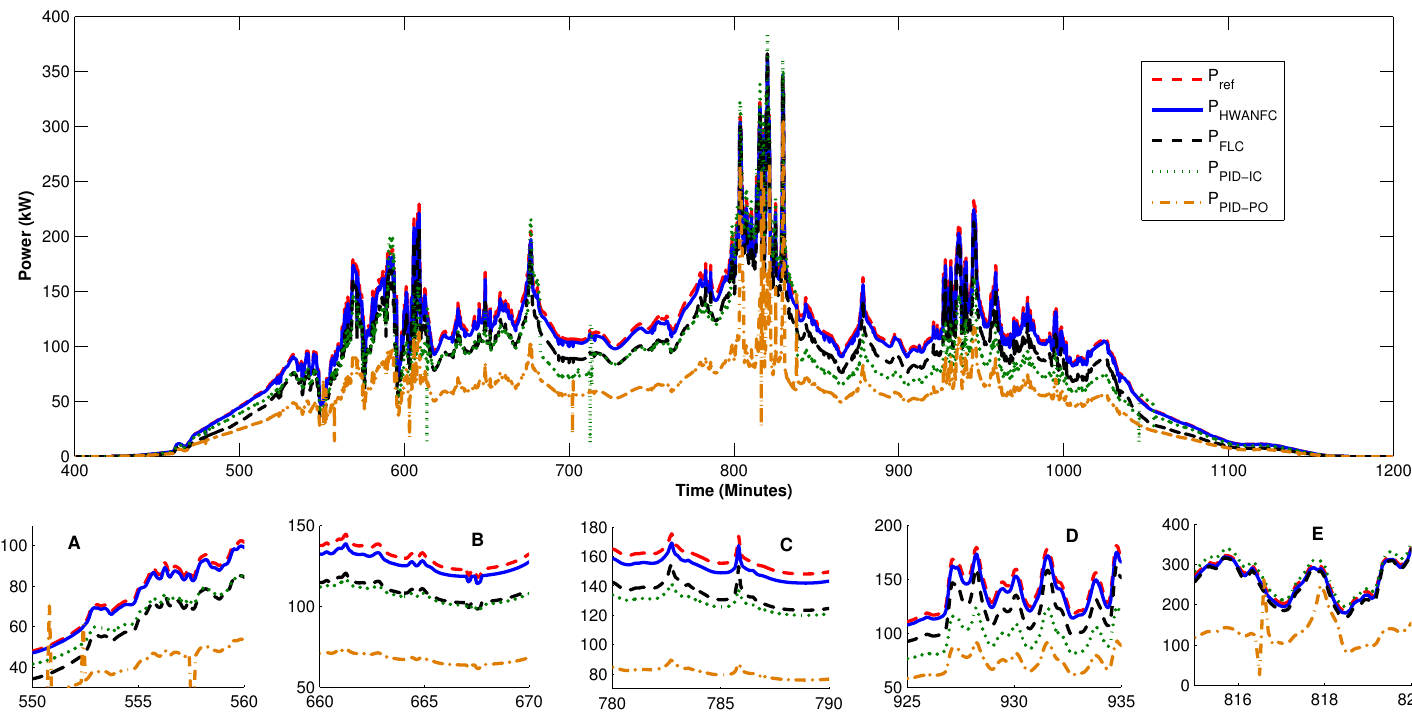
Figure 7. PV output power comparison ( A ) At t = 550–560 min; ( B ) At t = 660–670 min; ( C ) At t = 780–790 min; ( D ) At t = 925–935 min; ( E ) At t = 815–820